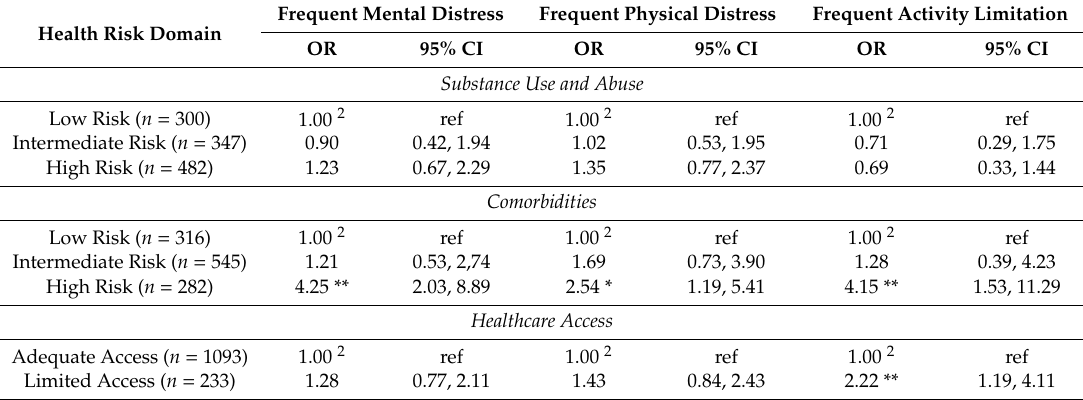
Table 2. Odds ratios (ORs) of frequent physical distress, mental distress, and activity limitation by individual and healthcare system risk domains, employed adults reporting diagnosis of COPD in KY, NC, WV, and TN, BRFSS, 2016–2017 1 .